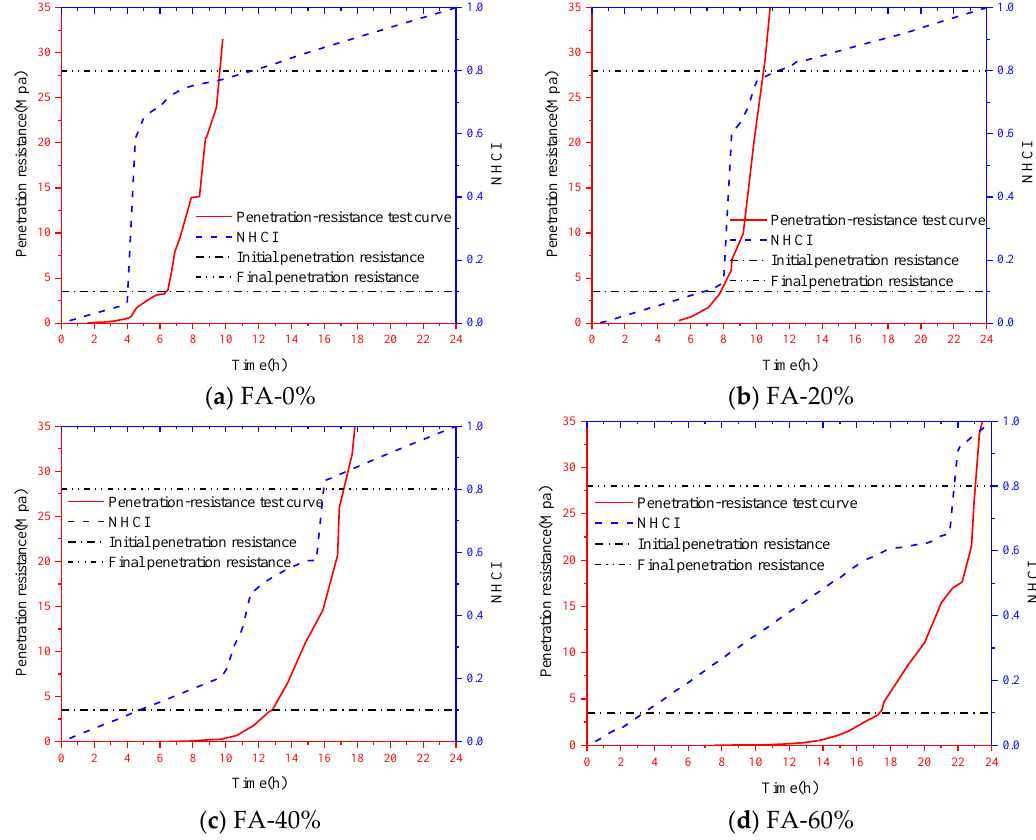
Figure 21. Comparison of the development process of NHCI values and the test results penetration resistance in the first 24 h after the casting of SCCs.